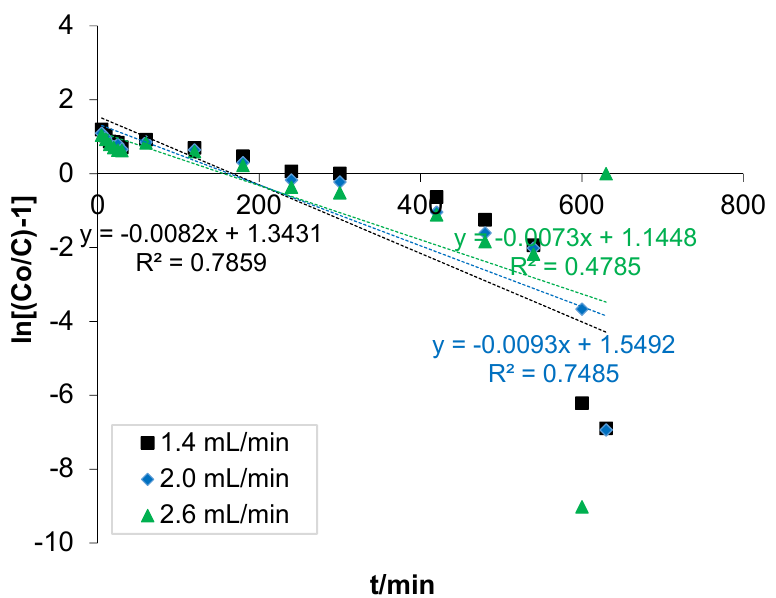
Figure 4. Linear plot of fitted data to the Thomas model.